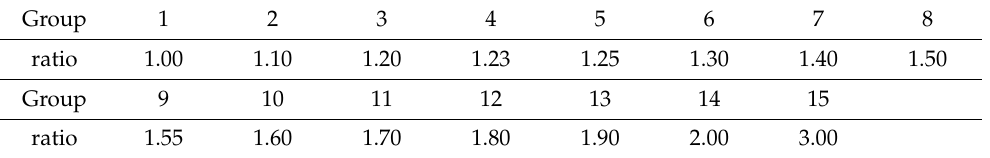
Table 2. Effective baseline size ratios.